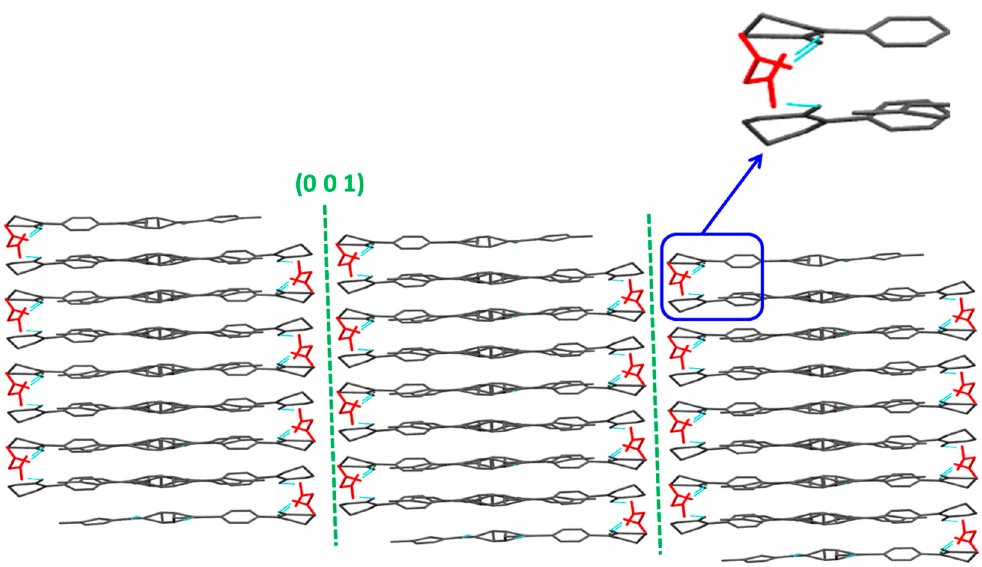
Figure 7. Crystal structure of RIV-MAL Co revealing the presence of flat layers topology slip plane along the (0 0 1) plane. MAL molecules are shown as “red”, RIV in “black” and hydrogen bonding interaction between RIV and MAL as “cyan”. The “insert” shows increased intermolecular interactions along the weakest crystallographic plane due to incorporation of MAL in the crystal lattice.